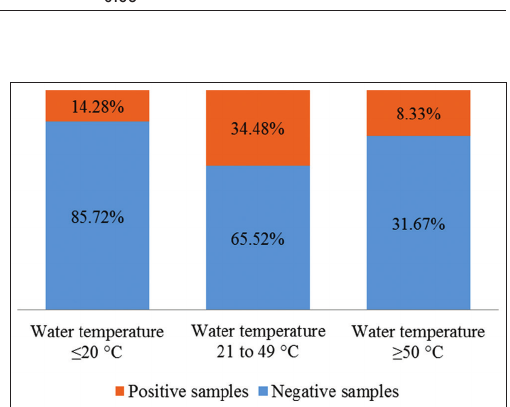
FIGURE 1. The percentage ratio of positive and negative samples for the presence of Legionella in water samples from taps with a different range of measured